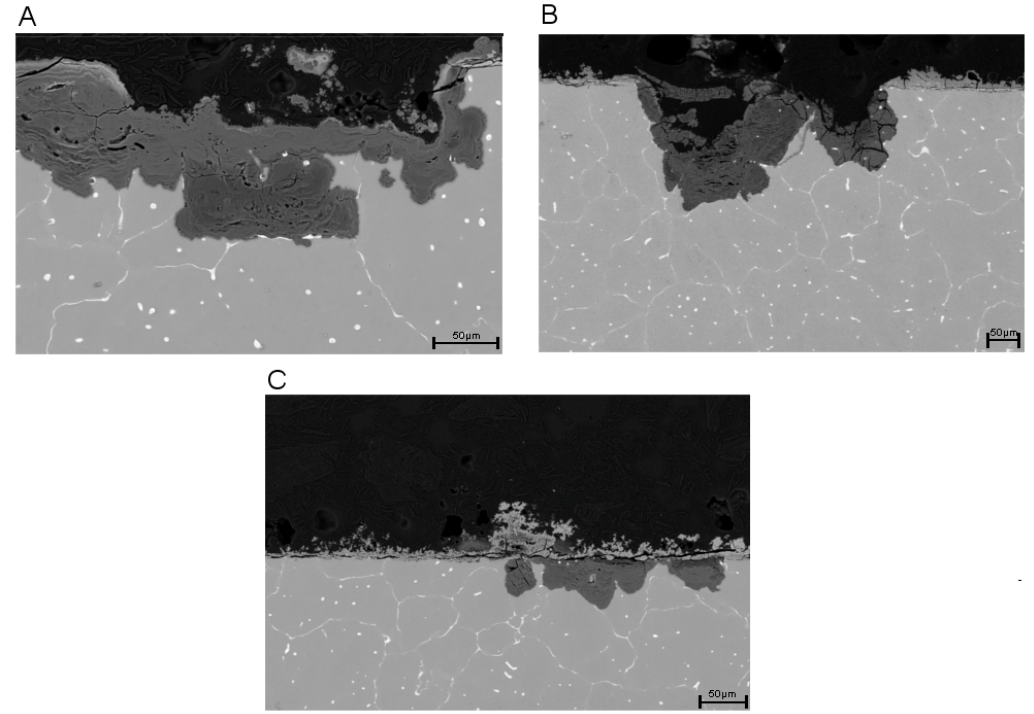
Figure 3. Scanning electron micrographs of the microstructure of Mg-0.6Ca-0.8 wt.% Zn Alloys for ( A ) 10 days in Hank’s solution, ( B ) 10 days in artificial saliva or ( C ) in AS / HS (5 days artificial saliva, 5 days Hank’s balanced solution).